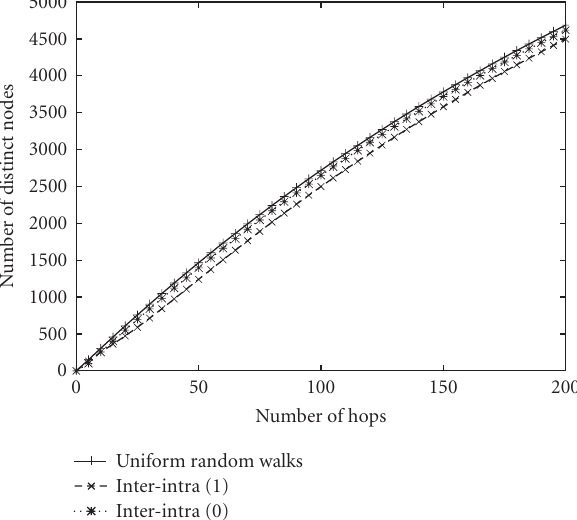
Figure 14: The total number of distinct nodes discovered within a specific hop